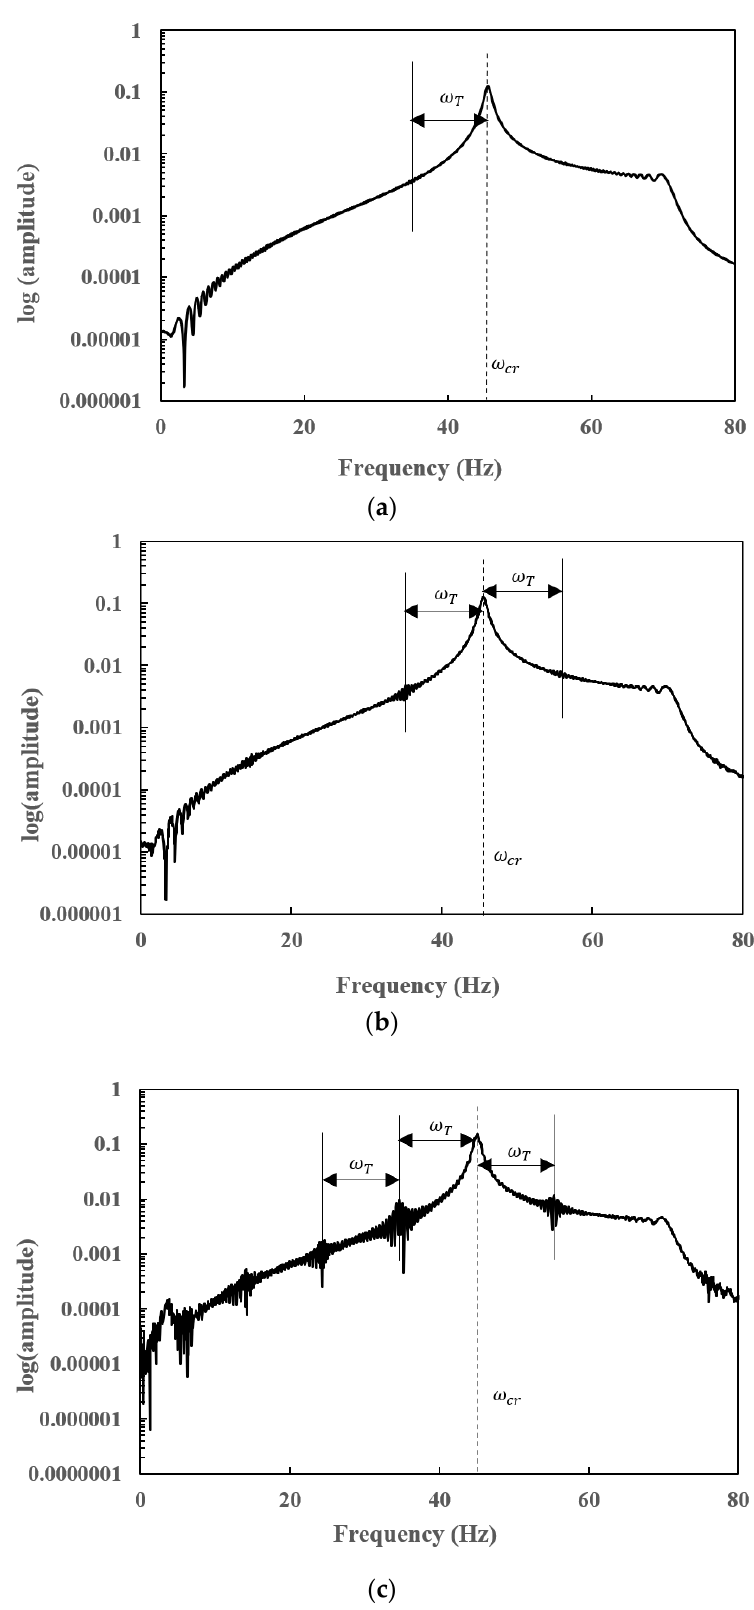
Figure 15. Transient FFT of a slant − cracked EG rotor − bearing system with an angular acceleration of 30 rad/s 2 , and torsional frequency ( ω T ) = 65 rad/s for ( a ) α = 0.1 ( b ) α = 0.2 and ( c ) α = 0.4, respectively.